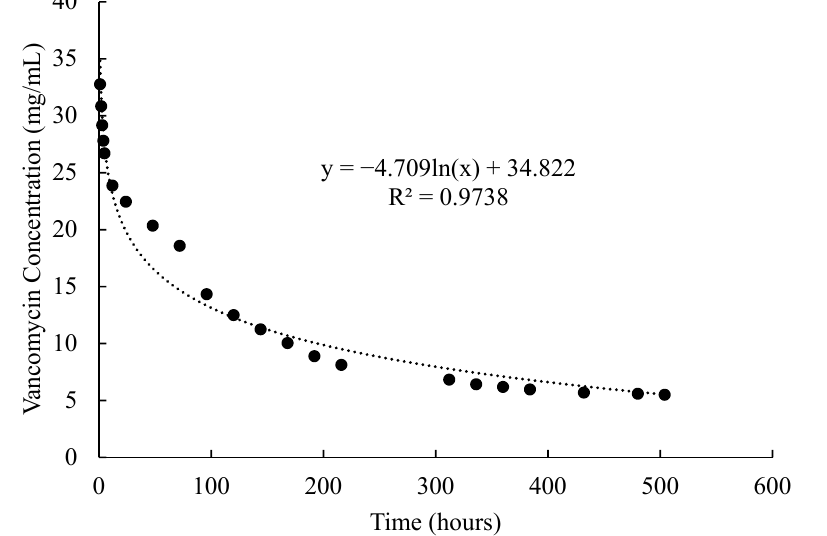
Figure 1. Vancomycin concentration over time as it diffuses out of the PNIPAAm-PEG-DA hydrogel. An equation of the line was fitted to the data and the equation was extrapolated to describe the change in hydrogel concentration over time for the model described.